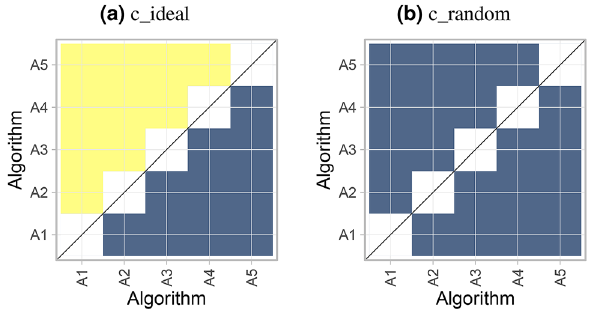
Figure 7. Significance maps for visualizing ranking stability based on statistical significance. They depict incidence matrices of pairwise significant test results e.g. for the one-sided Wilcoxon signed rank test at 5% significance level with adjustment for multiple testing according to Holm. Yellow shading indicates that metric values of the algorithm on the x-axis are significantly superior to those from the algorithm on the y-axis, blue color indicates no significant